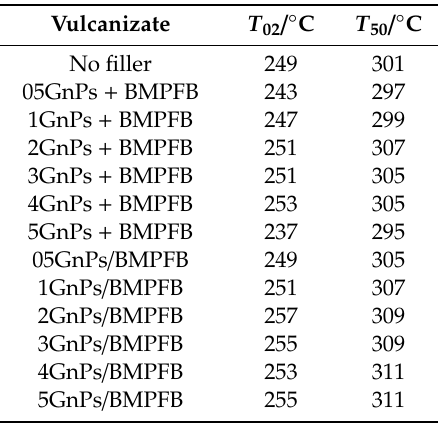
Table 4. TG data of SBR